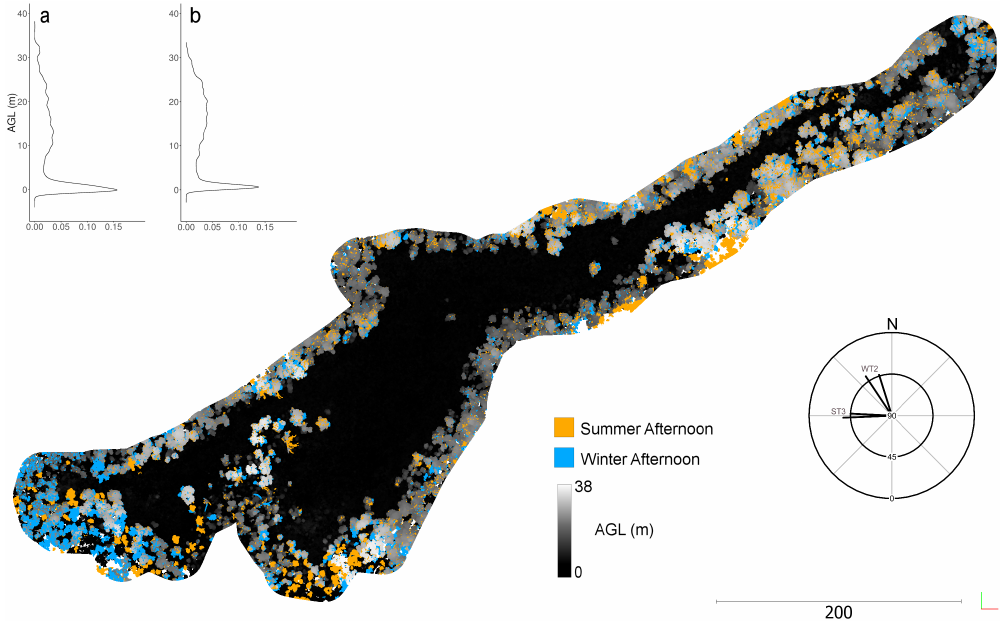
Figure 15. (main) Dense point cloud reconstruction with ST3 (red to yellow) and WT2 (blue) compared to features separated by < 0.5 m in both products combined and displayed as a height ramp (black–white). Elevations for all products are calculated as z distance component from a red cloud 2 m minimum subsample to remove underlying terrain. The relative frequency of uniquely reconstructed point features for ( a ) ST3 and ( b )